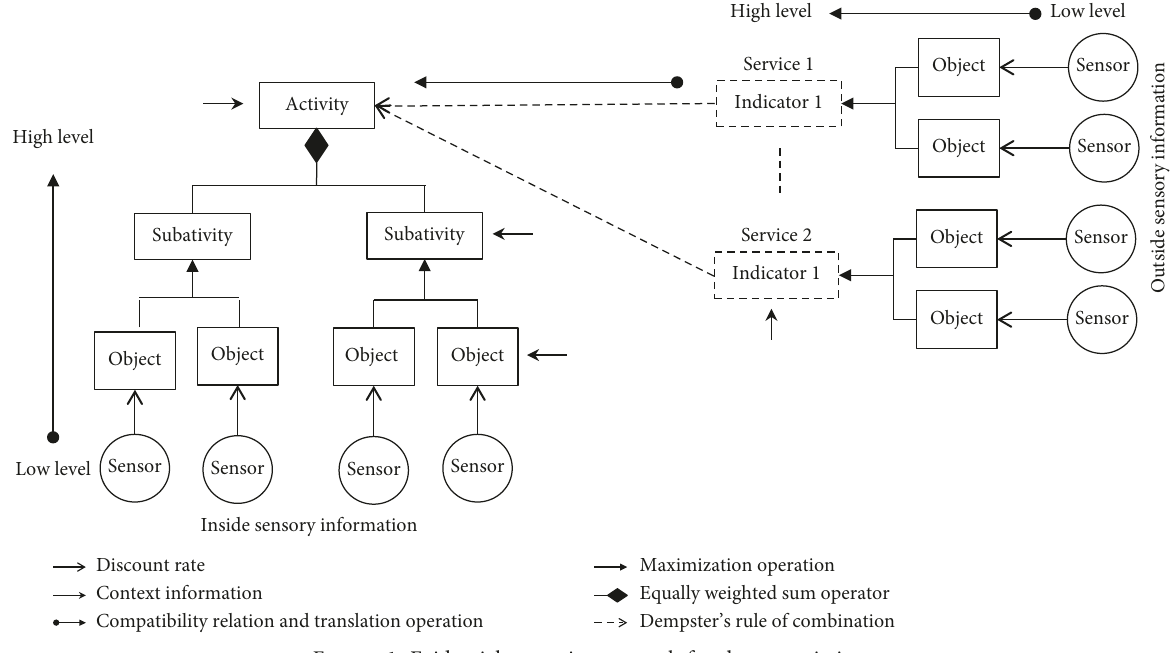
Figure 1: Evidential reasoning network for data association.